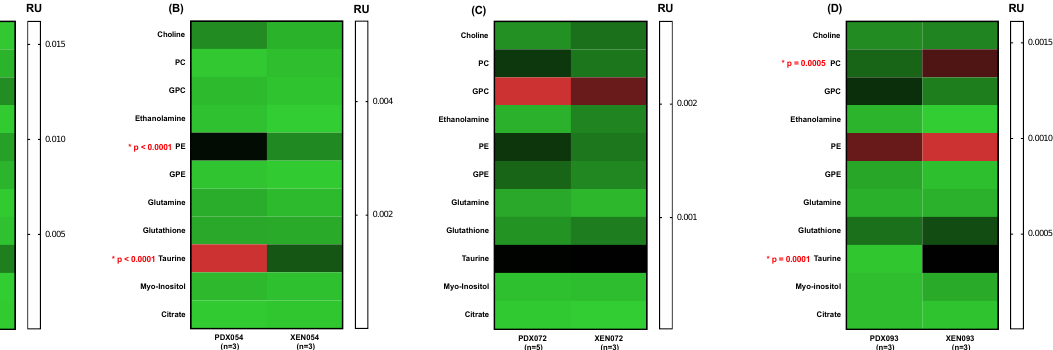
Figure 6. Heat maps showing absolute concentrations of steady state metabolites between PDX and their corresponding cell culture-derived XEN: ( A ) PDX/XEN047; ( B ) PDX/XEN054; ( C ) PDX/XEN072; ( D ) PDX/XEN093. * indicates statistical significance.